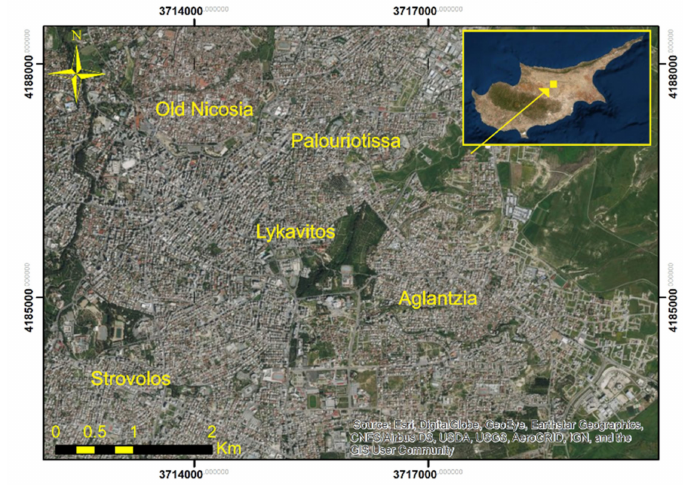
Figure 1. Satellite image of the study